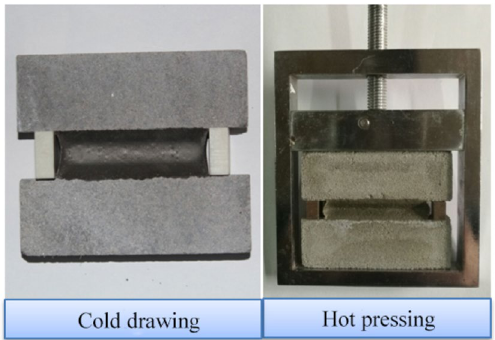
Figure 3. Cold drawing and hot pressing.